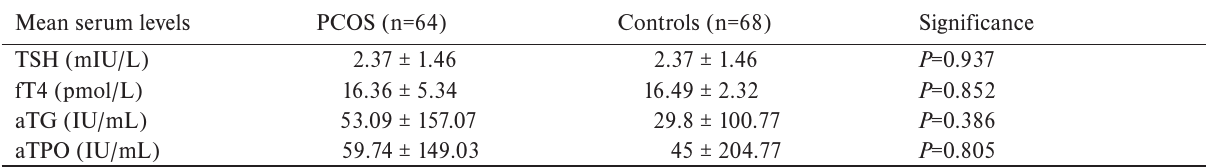
Table 2. Mean serum levels of thyroid parameters in PCOS women and controls.